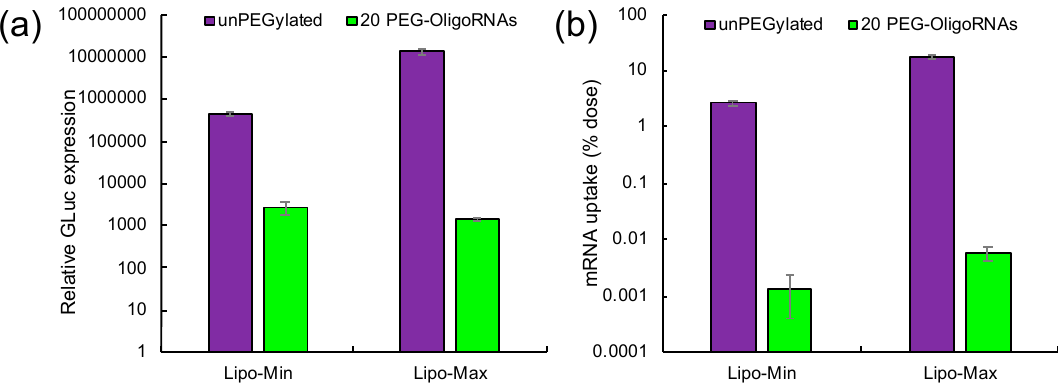
Figure 7. Introduction of Lipofectamine LTX/mRNA LNPs to cultured cells. Two LNP formulations were prepared by mixing GLuc mRNA with minimal or maximal volume of lipofectamine LTX solution that the manufactures suggest to use (Lipo-Min and Lipo-Max). LNP loaded with non-PEGylated mRNA and that loaded with 20 PEG-OligoRNAs/mRNA were transfected to HuH-7 cells. ( a ) GLuc protein concentration in the culture medium 4 h after the transfection. n = 6. ( b ) GLuc mRNA uptake to HuH-7 cells measured using qRT-PCR 4 h after the transfection. n = 4. Data are presented as mean ± standard error of the mean.